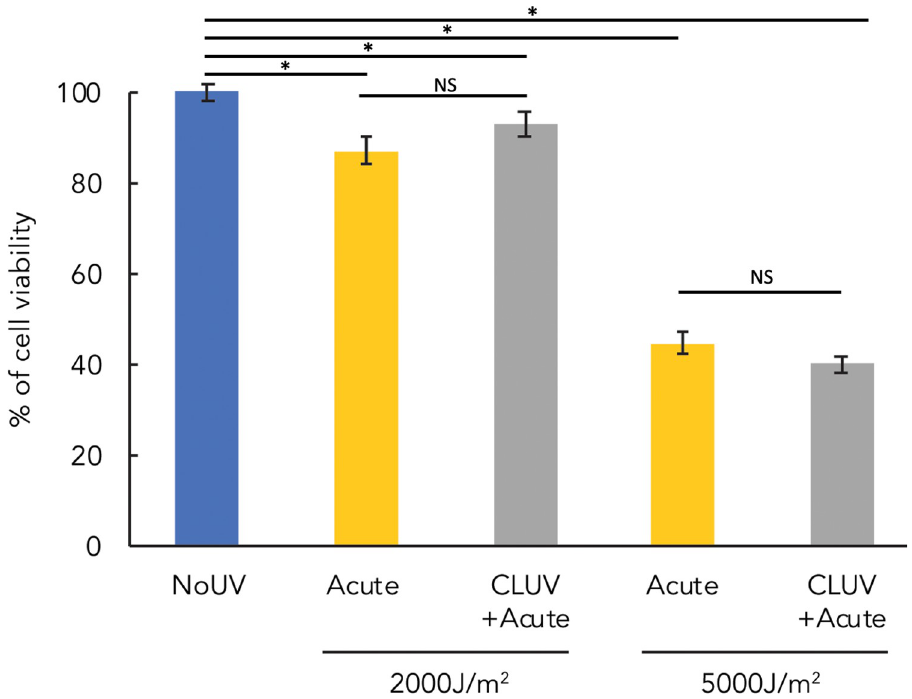
Fig 5. Sensitivity to UVB-induced cell death after a CLUV pre-stimulation. Keratinocytes pre-stimulated or not with the CLUV treatment were irradiated with an acute lethal exposure of 2,000 J/m 2 or 5,000 J/m 2 of UVB. Cellular